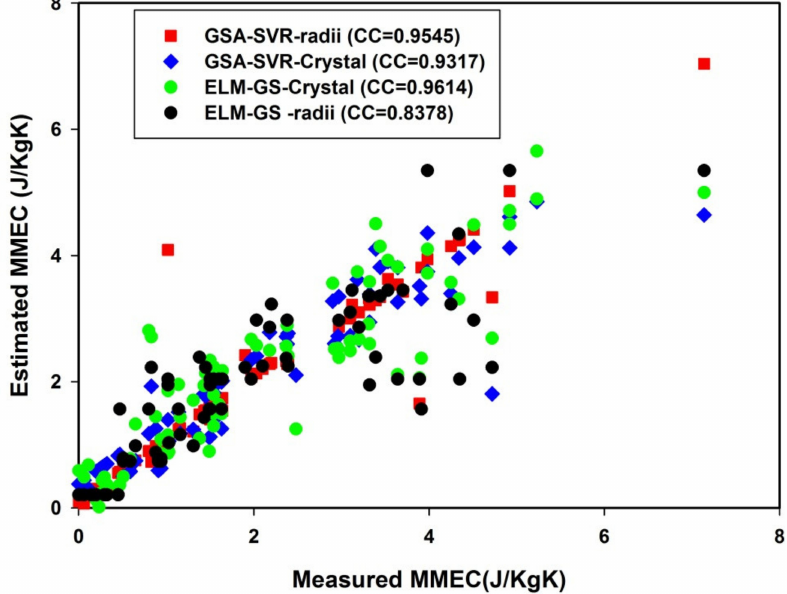
Figure 9. Correlation cross-plot between the measured and estimated MMEC for all developed models using the training set of data.